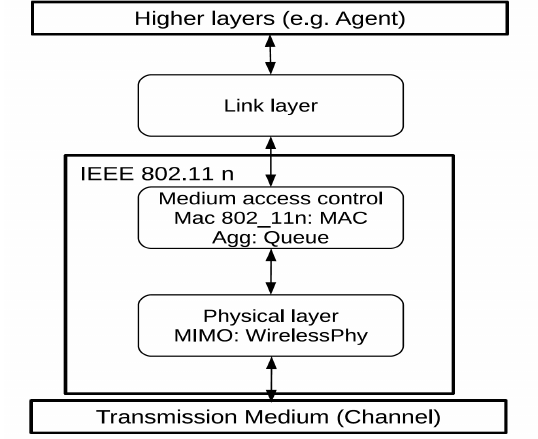
Figure 1. IEEE 802.11n implementation in Network Simulator